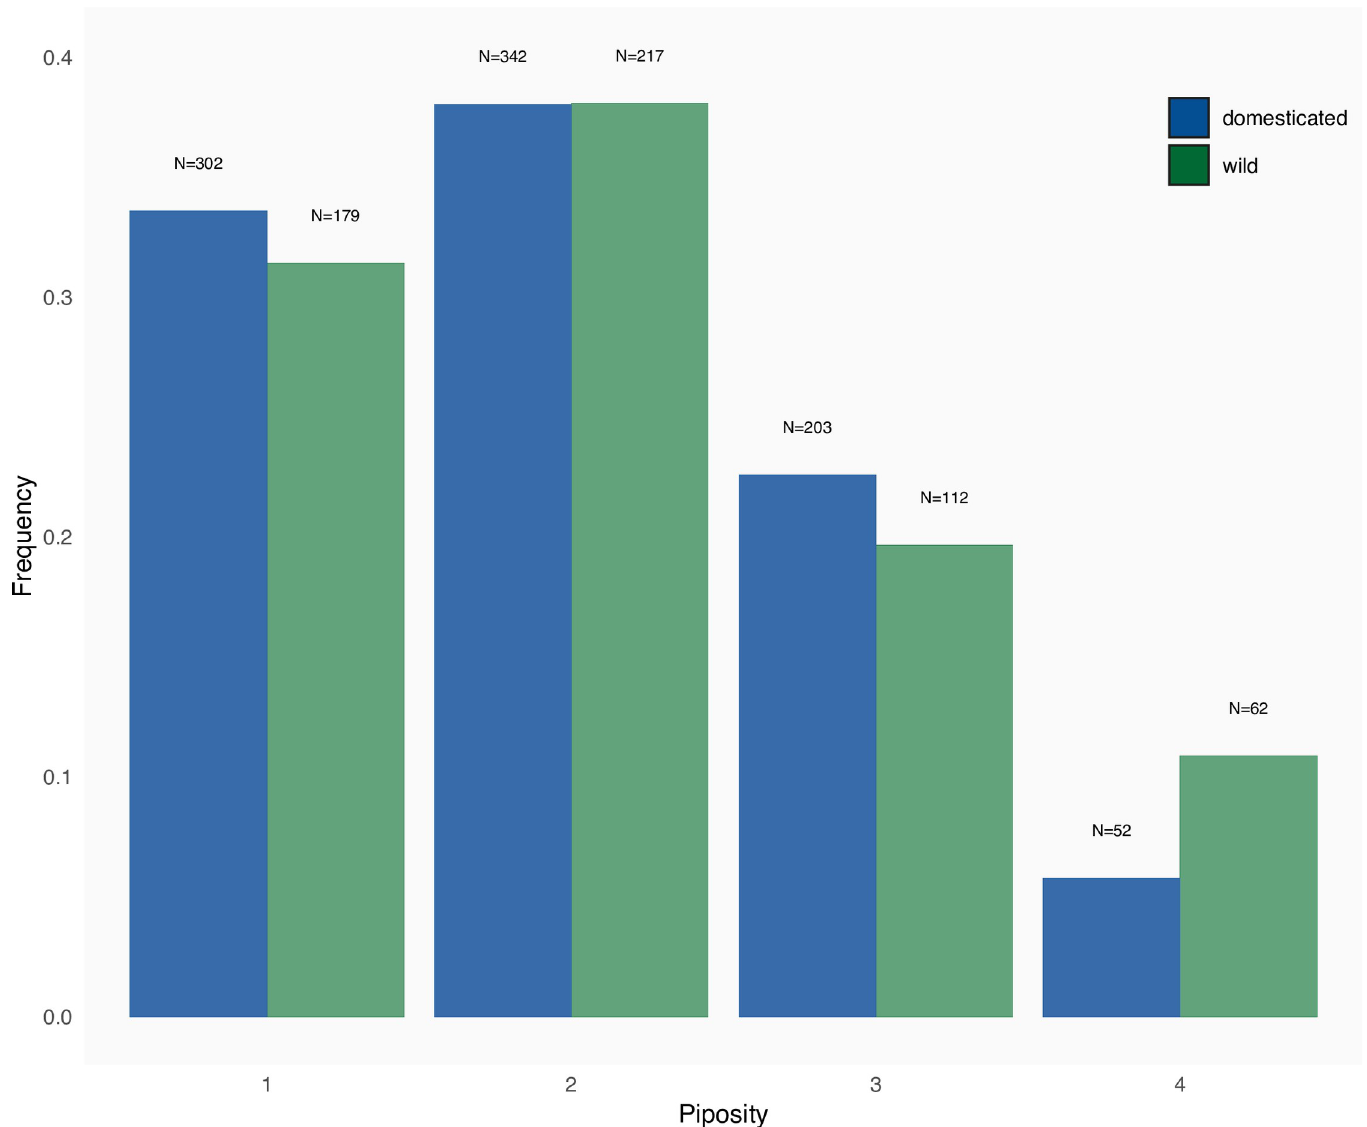
Fig 1. Distribution of the number of pips per berry for wild and domesticated grapevines.